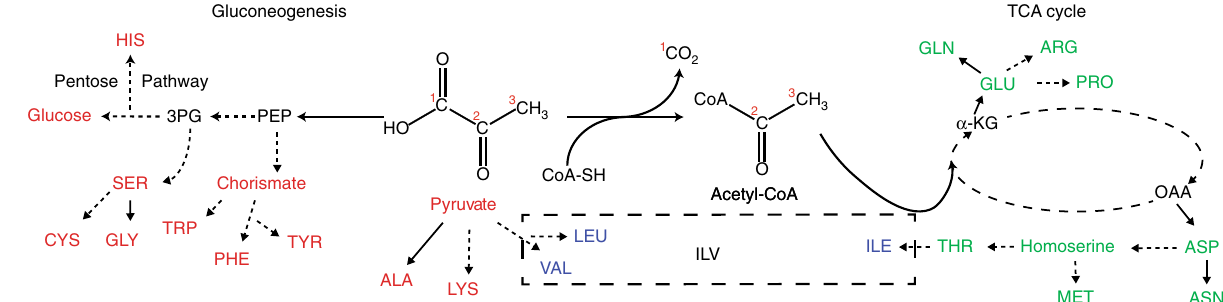
Fig. 1 The principal metabolic pathways that lead from pyruvate to the amino acids. Direct conversion between molecules is indicated with solid lines while pathways involving one or more intermediates is indicated with dashed lines. With pyruvate as the only carbon source, gluconeogenesis (left) results in “ directly ” synthesized amino acids (red). The pyruvate carbons are numbered with red numerals. The TCA-derived amino acids (right, green) are synthesized when acetyl-CoA from pyruvate enters the cycle. The ILV amino acids (dashed box) derive their C β atom from more complicated metabolism as discussed in the